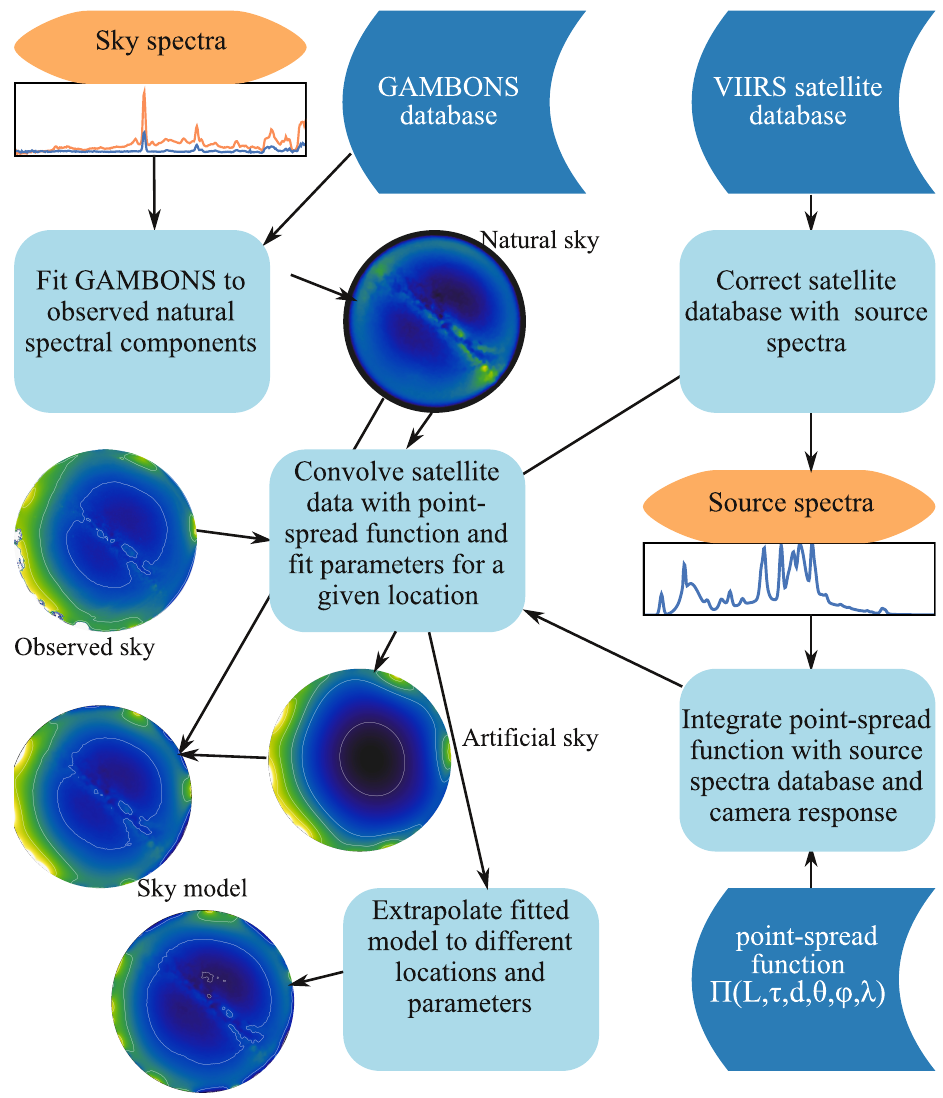
Figure 8. Flowchart of model